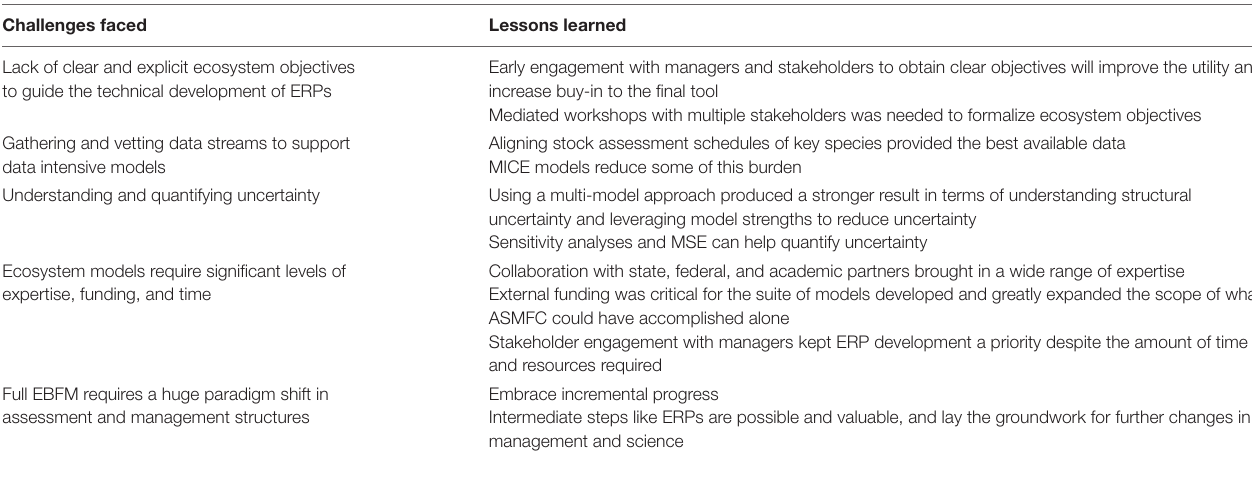
TABLE 4 | Key lessons learned from the ASMFC ERP